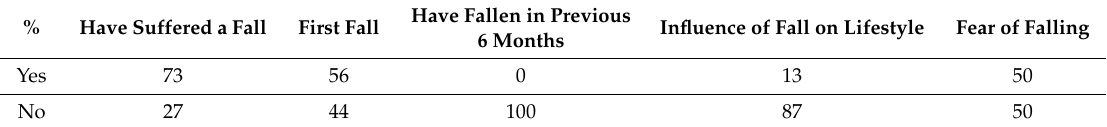
Table 1. Description of the sample according to fall history and incidents.